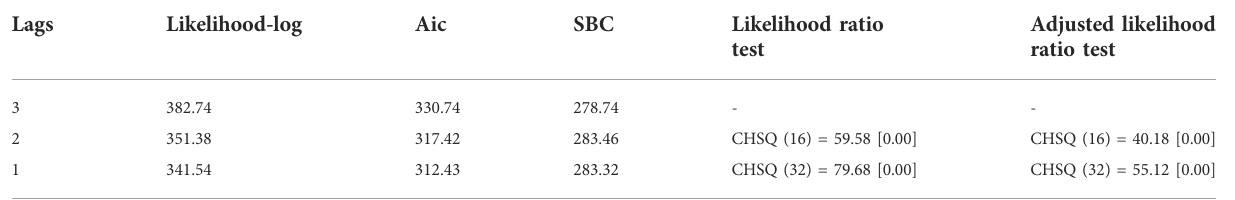
TABLE 1 Test statistics along with selection criterion choice of V.A.R. model.